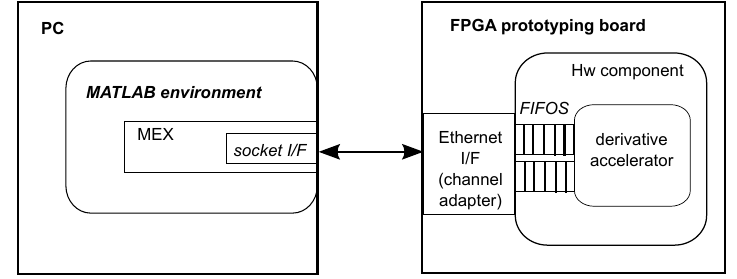
Figure 2. MATLAB Hardware prototyping